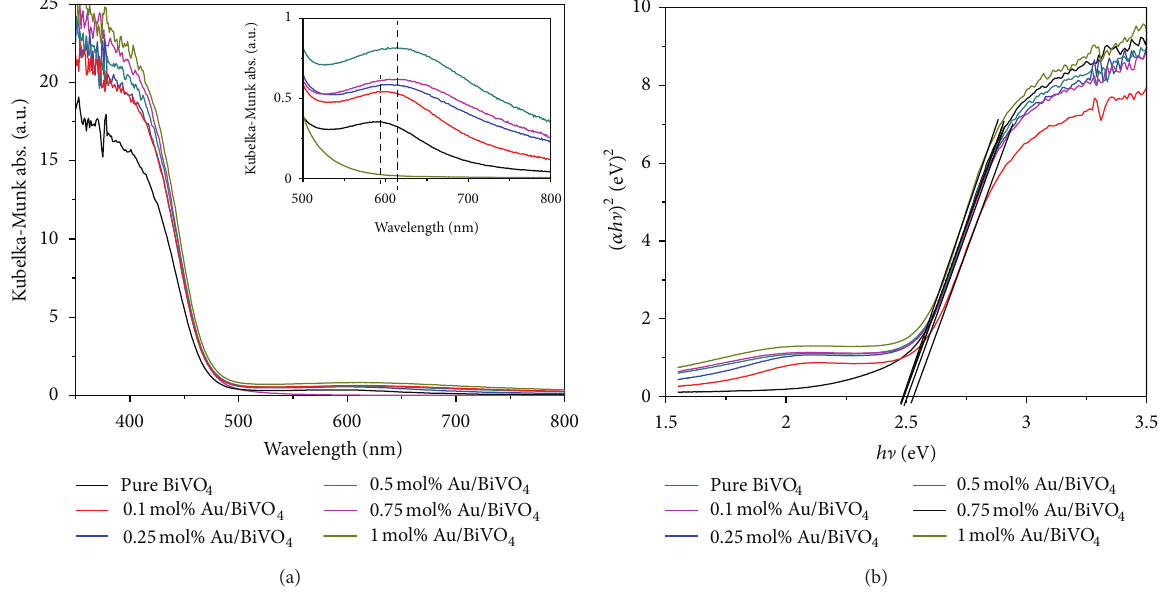
Figure 3: (a) UV-Vis diffuse absorption spectra of pure BiVO 4 and Au/BiVO 4 with an inset showing an enlarged image of the absorption in the range of 500–800 nm and (b) the plots of ( 𝛼 h ] ) 2 versus photon energy ( h ] ).